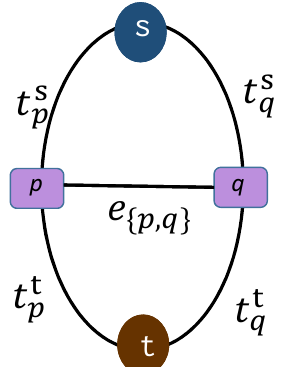
Figure 4. A graph with only two pixels in one dimension. Here we have four vertices (two pixels: p and q ; two terminals: s and t) and five edges (four terminal links (t-links): t s p , t s q , t t p , t t q ; and one neighbor link (n-link): e { p , q }